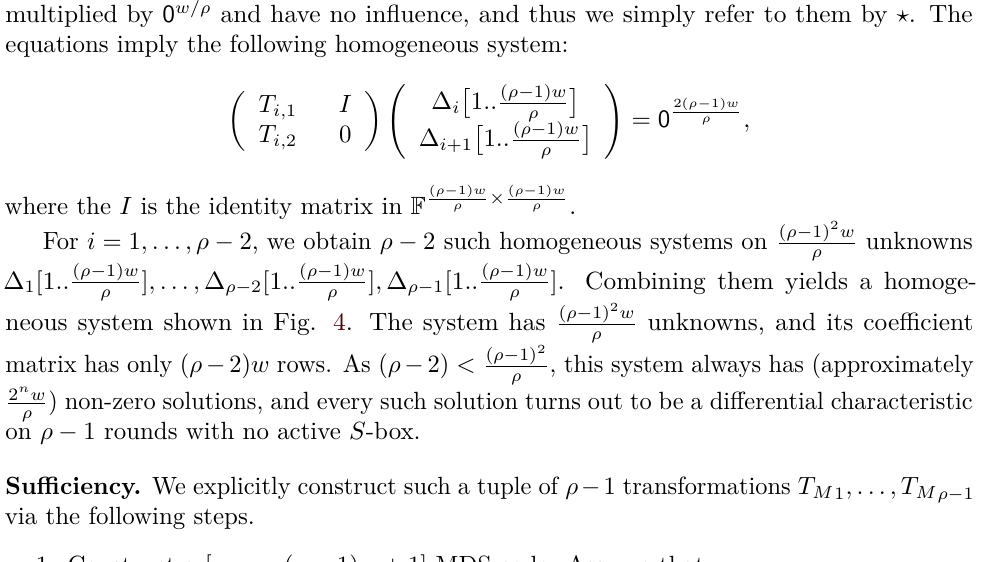
. The right most w columns of T i ρ